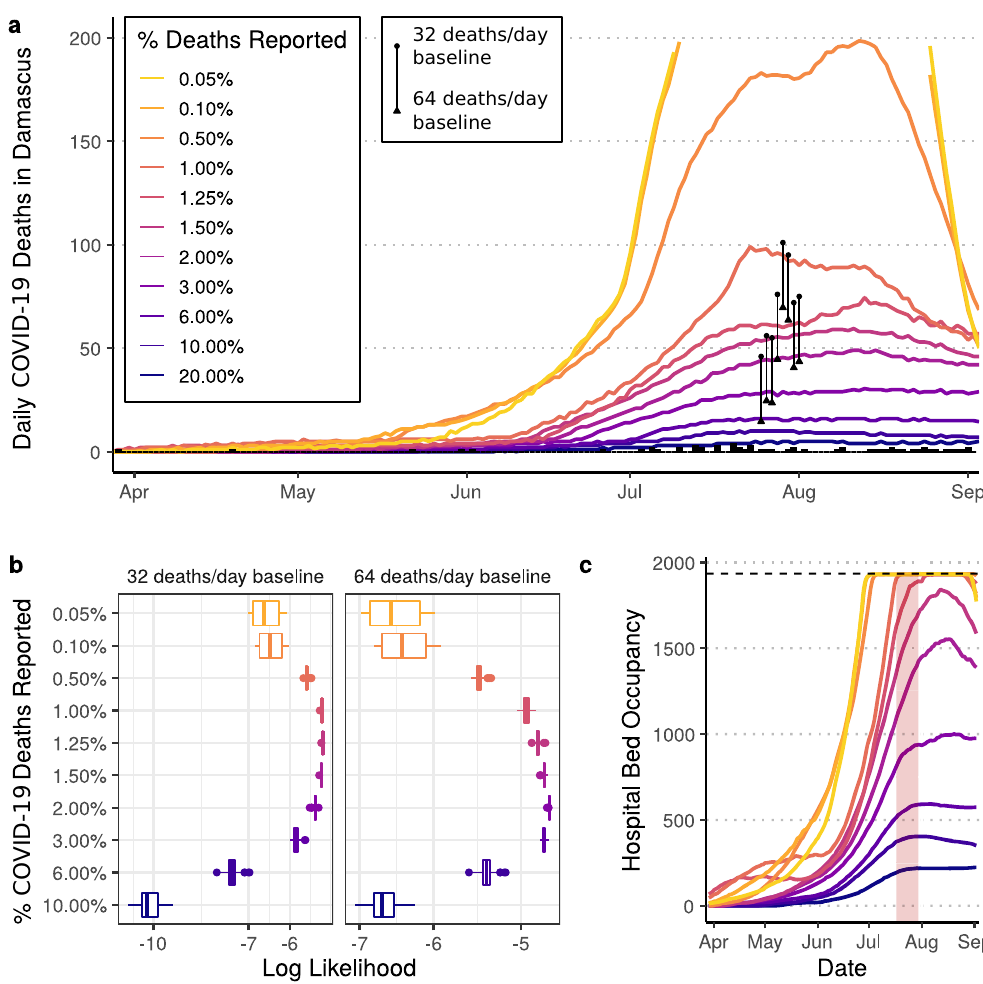
Fig. 1 Estimates of under-ascertainment of deaths in Damascus. In ( a ) the daily model-predicted COVID-19 deaths in Damascus are shown using the default model parameters and a range of values for the under-ascertainment of COVID-19 deaths. These are compared to the excess mortality reported by the government during 25 July – 1 August, which is shown with point ranges, with estimates assuming a baseline of 32 and 64 deaths per day shown with a circle and triangle respectively. Trajectories with 0.05 and 0.1% of deaths reported are not shown above 200 daily deaths to ease viewing of other curves. In ( b ) the log likelihood for each level of under-ascertainment is shown for different assumed baseline mortality. Model log likelihoods presented re fl ect the mean model log likelihood across the full sensitivity analysis conducted ( n = 14,000), suggesting that under-ascertainment is likely between 1 and 3% when viewed across both baseline mortality estimates. The box represents the median and interquartile range (IQR) and whiskers represent the IQR ± 1.5*IQR with points depicting values outside this range. In ( c ) the model-predicted hospital occupancy for the simulations in ( a ) are shown. The hospital capacity for Damascus is shown with a dashed horizontal line, with the 2-week period in which hospitals were reported to be fi rst at capacity shown shaded in red. In both ( a , c ) the median of 100 draws from the posterior parameter space are presented for visualisation